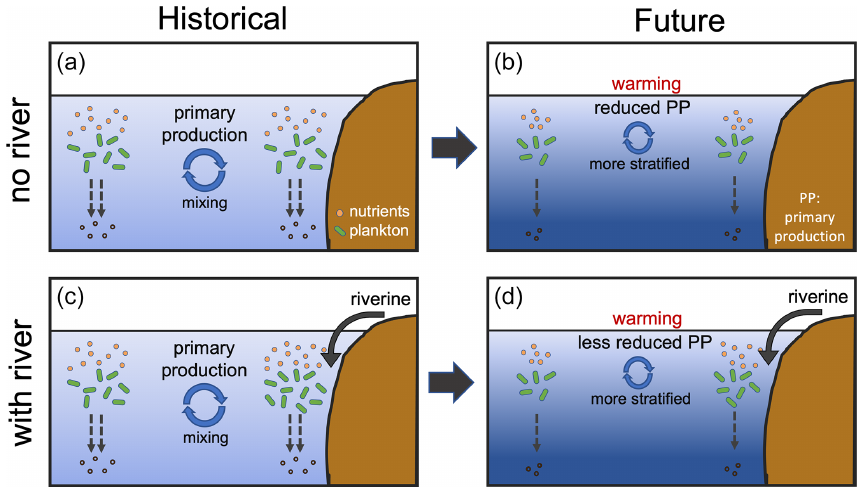
Figure 12. Schematic drawing of impact of riverine nutrient input on future projections of marine primary production. (a, b) Decline in nutrient supply into subtropical surface waters due to the upper-ocean warming and increased vertical stratification, which is projected by models to reduce primary production over the 21st century. (c, d) Riverine nutrient input into surface coastal waters alleviates the nutrient limitation and lessens the projected future decline in primary